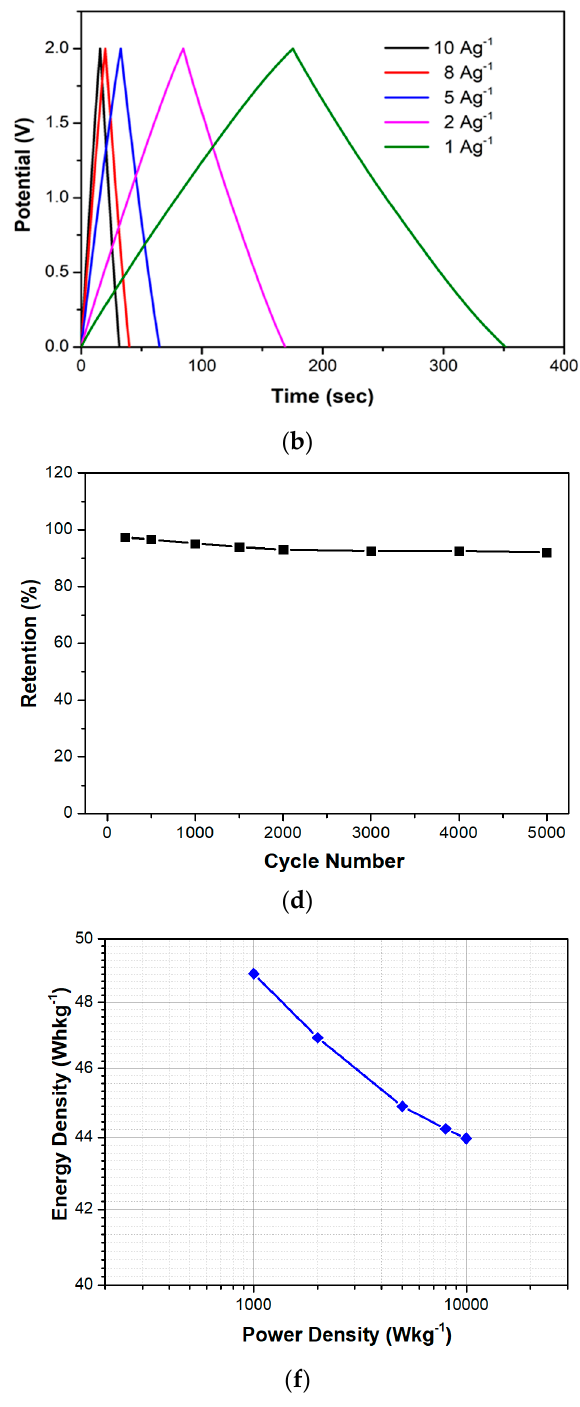
Figure 5. Electrochemical characteristics of a single as-prepared symmetric supercapacitor device of CSCK2/Ni//CSCK2/Ni: ( a ) CV curves at different sweep rates and a voltage window of 2 V; ( b ) GCD curves at various current densities; ( c ) plot of C device versus current density; ( d ) cycling performance at a current density of 2 A g − 1 ; ( e ) Nyquist plots obtained for 5000 cycles; and ( f ) Ragone plot acquired for the device.